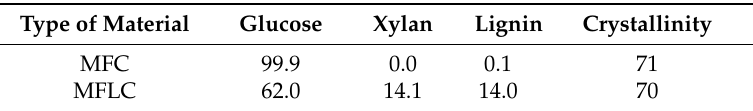
Table 1. Chemical composition of microfibrillated lignocellulose (MFLC) compared to microfibrillated cellulose (MFC) [25]. Type of Material Glucose Xylan